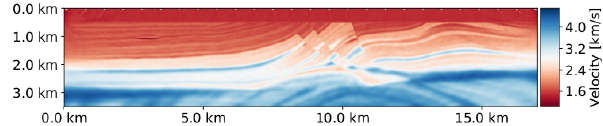
Figure 19. Velocity model computed by the FWI execution with HABC-Higdon and a multiscale approach (Bunks et al.,